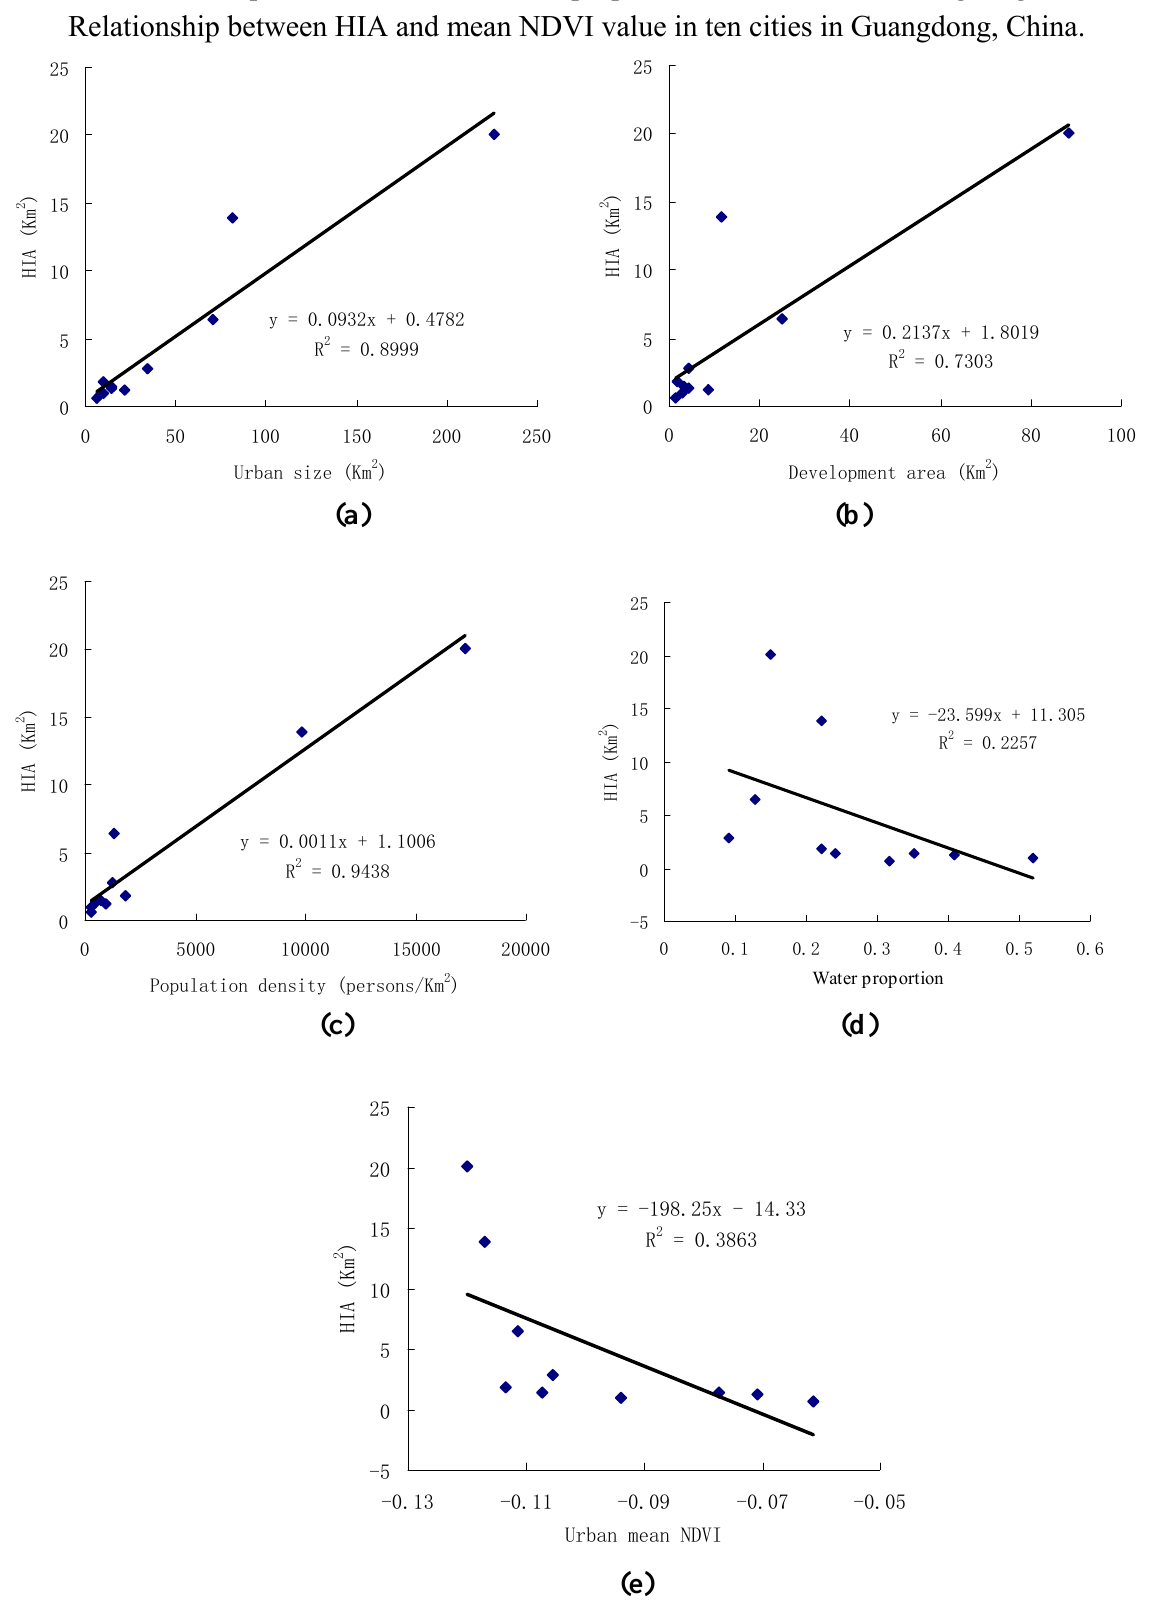
y = 0.0932x + 0.4782 R 2 =